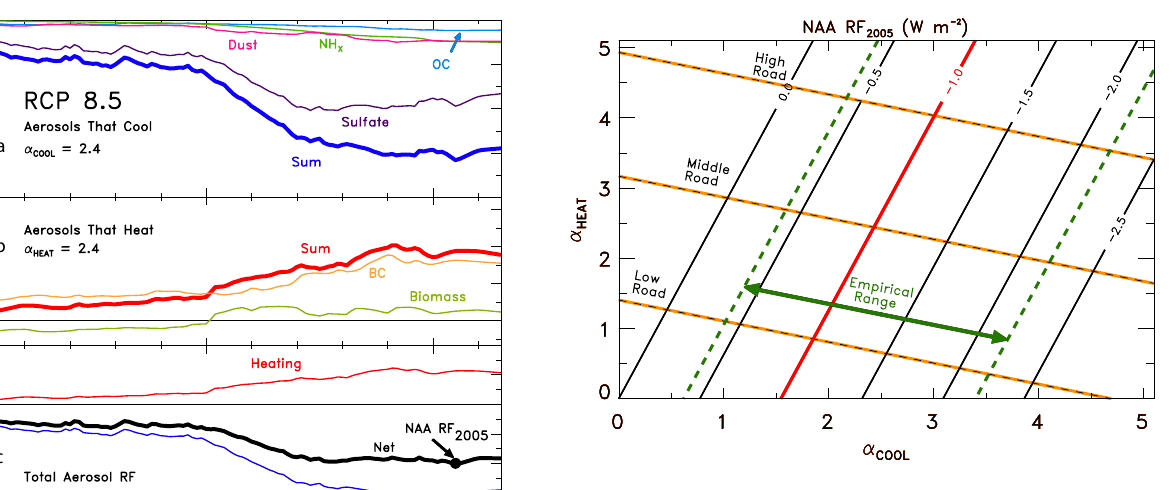
Fig. 4. Contours of net anthropogenic aerosol RF in year 2005 (NAA RF 2005 ) (black solid lines) as a function of α COOL and α HEAT , scaling parameters used to relate direct RF of aerosols to total RF. The contour for NAA RF 2005 = − 1 . 0Wm − 2 , the best estimate from IPCC (2007), is shown in red. The dashed green lines denote the range of NAA RF 2005 inferred from data analyses given in Table 2.12 of IPCC (2007) (Appendix C). The black dashed/yellow highlight lines denote various manners upon which values of NAA RF 2005 , ranging from the lower limit of − 2 . 2Wm − 2 to the upper limit of − 0 . 4Wm − 2 , can be sampled. RF SULFATE − TOT in year 2005 is − 0 . 96 Wm − 2 , based on values of RF SULFATE − TOT from Stern (2006a) that